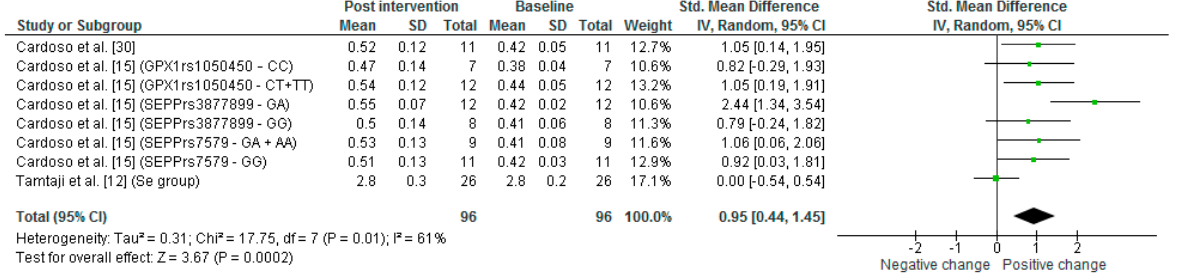
Figure 5. Meta-analysis of MDA levels in plasma in only selenium supplementation studies pre and post Se supplementation. Tamtaji et al. [12] is the only study that underwent treatment for 12 weeks in the other studies the Se supplementation underwent 24 weeks. AD: Tamtaji et al. [12]; MCI: Cardoso et al. [30]; Cardoso et al. [15].